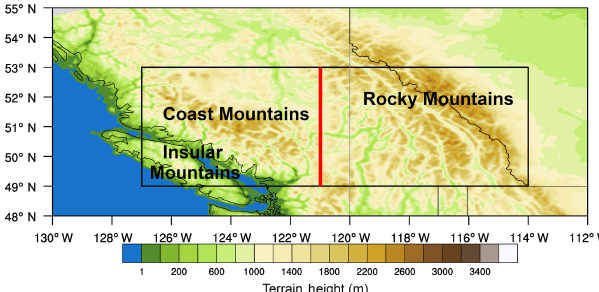
Figure 1. Map of study area with terrain height shaded over the southern Canadian Cordillera, delineated by the solid black rectan- gle from 114 to 127 ◦ W and from 49 to 53 ◦ N. The red vertical line at 121 ◦ W separates the study area into western and eastern sub-